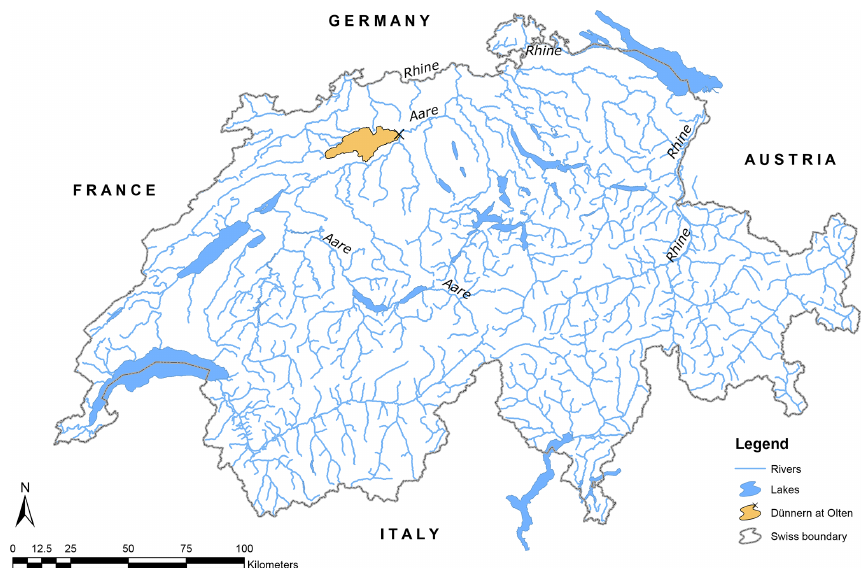
Figure 3. Location of the Dünnern at Olten catchment with a river network extracted from Swiss Map Vector 25 (SwissTopo, 2008).